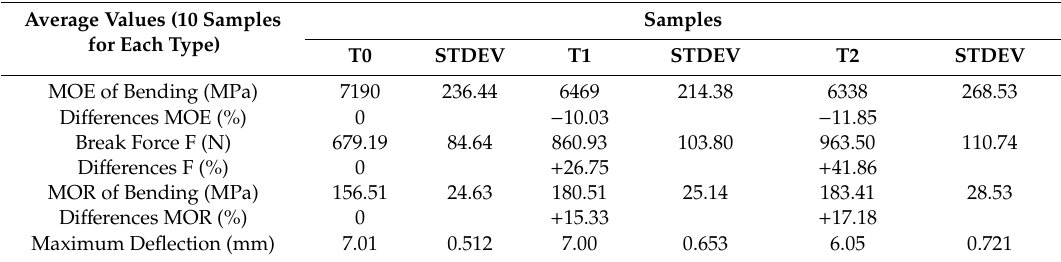
Figure 9. The characteristic curves to static three-point bending test ( a ) load versus deflection variation; ( b ) stress versus flexural strain variation. Table 2. Mechanical properties obtained from the static flexural test, due to the presence of ammonia in the black locust wood samples.